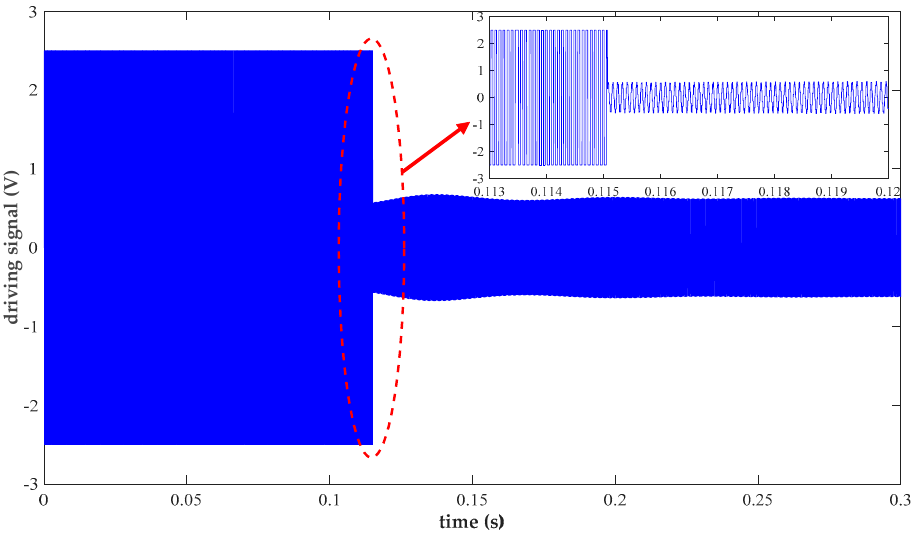
Figure 12. Measurement of the nonlinear drive loop.